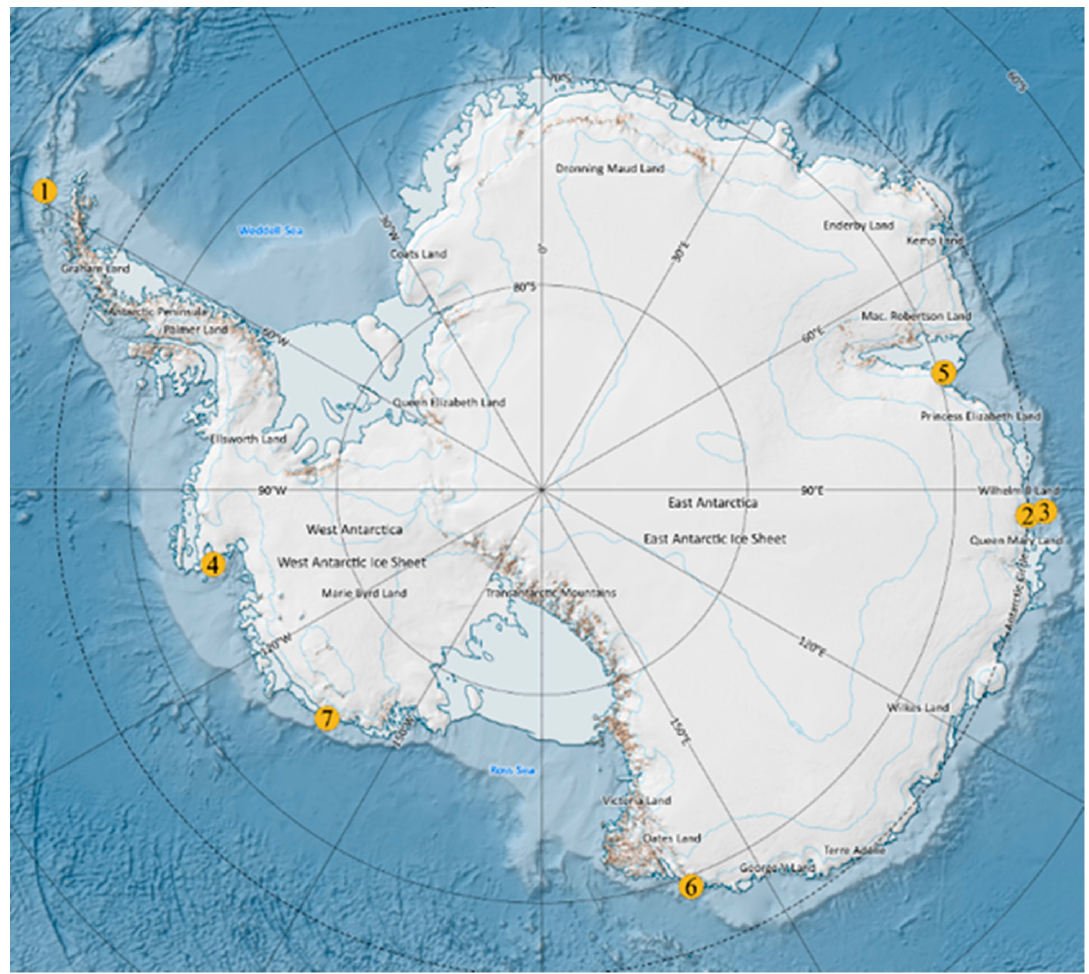
Figure 1. Localization of soil sampling sites in Antarctica: 1 —Bellingshausen Station, King George Island, 2 —Mirniy Station, 3 —the Haswell Archipelago, 4 —the Hudson Mountains, 5 —Druzhnaya 4 Station, 6 —Leningradskaya Station and 7 —Russkaya Station.